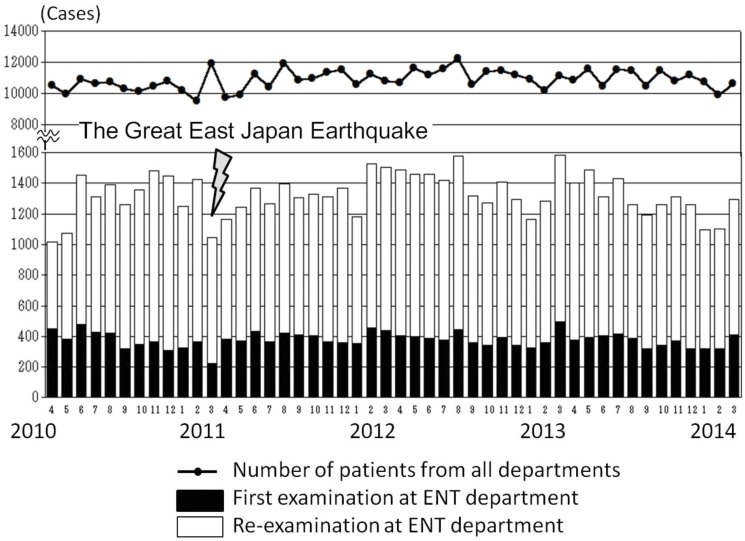
Number of outpatients from all the departments at Soma General Hospital, and the number of new patients and revisiting patients of the ENT department.Those patients who had not visited us for more than 6 months were regarded as new patients. After the disaster, the number of new patients increased 7.7% in the first year, 4.8% in the second year, but decreased 0.8% in the third year. Thus, the differences were small.